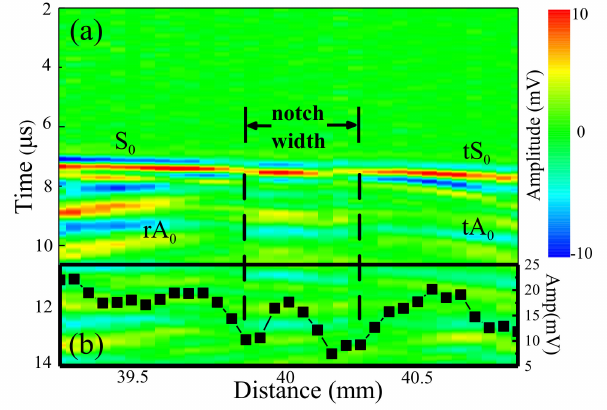
Figure 6. ( a ) B-scan image at the defect with scanning step of 0.05 mm; ( b ) Amplitude at the corresponding